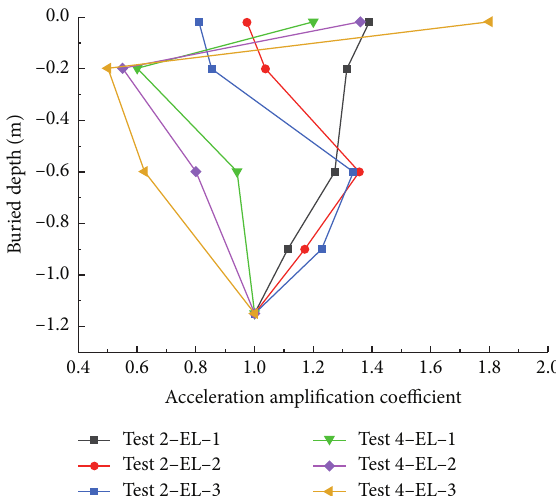
Figure 13: Case 3 acceleration amplification factor of soil layer.